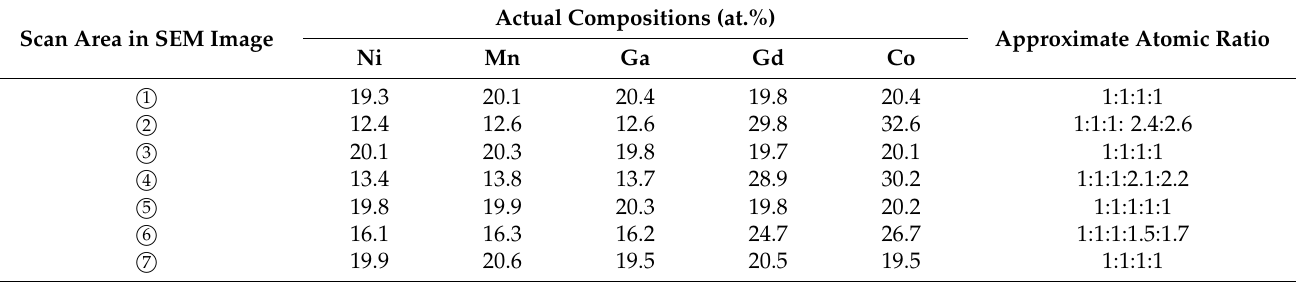
Table 2. The element distribution of the samples by EDS analysis.